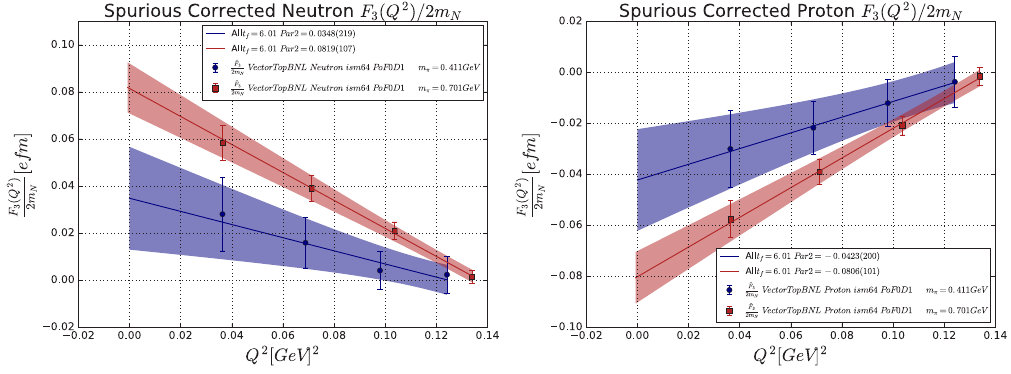
Figure 4. CP-odd vector form factor F 3 / 2 m N in units of α W / Λ 2 for the neutron (left) and proton (right), induced Figure 6. Corrections suggested by [21] for the CP-odd vector form factor F 3 / 2 m N in units of θ for the neutron via the Weinberg operator CP-violating vacuum, plotted against transfer momentum Q 2 . Blue and red points are (left) and proton (right), induced via the θ -term CP-violating vacuum, plotted against transfer momentum Q 2 . the m π = 411 , 701 MeV results respectively. The linear fit to Q 2 Blue and red points are the m π = 411 , 701 MeV results respectively. The linear fit to Q 2 0 is used to extract the value for the neutron → and proton EDM d n / p . the value for the neutron and proton EDM d n / p .